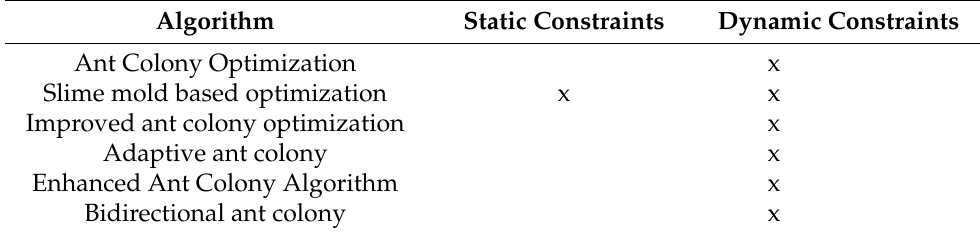
Table 6. Classification of the ant colony algorithm and its variants based on static and dynamic